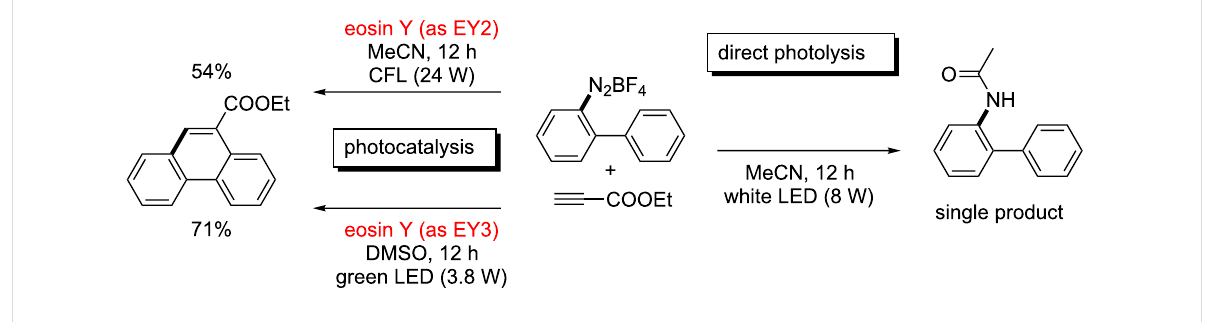
Quantum yields of eosin Y-catalyzed